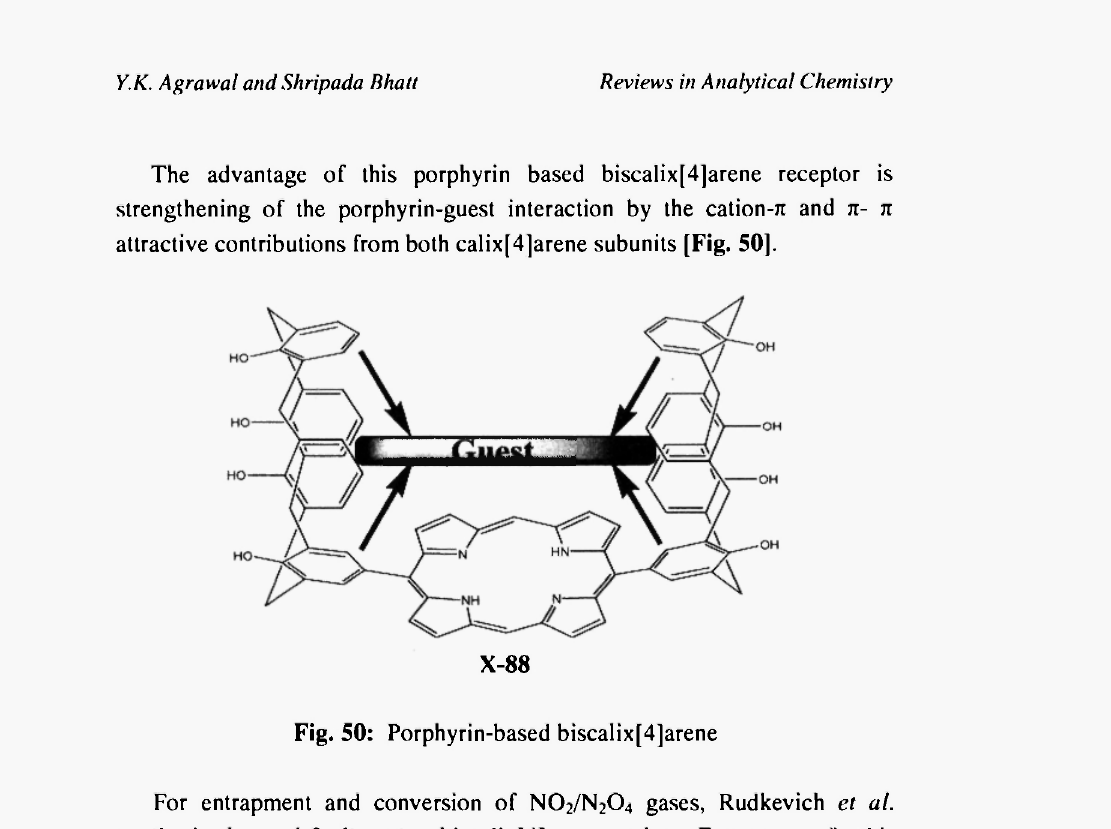
Fig. 50: Porphyrin-based